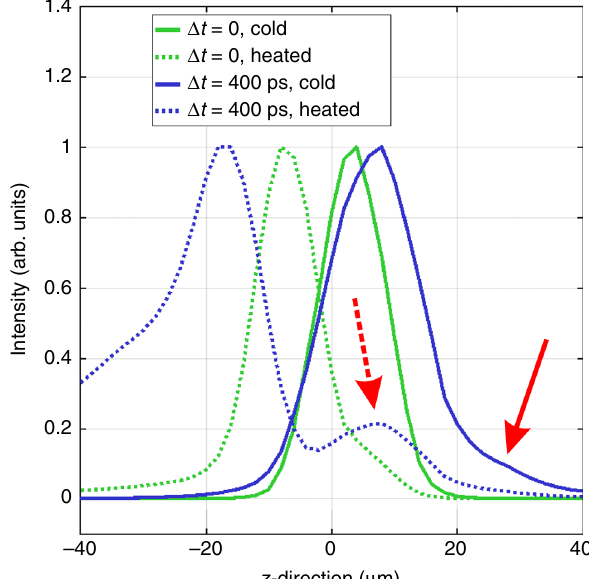
Fig. 7 Effect of temporal delay on the X-ray emission. Simulated spatial distribution of K α -radiation emitted from cold and heated plasma regions. The electron distribution has a Gaussian pro fi le delayed by Δ t ¼ 0 or 400 ps versus the laser